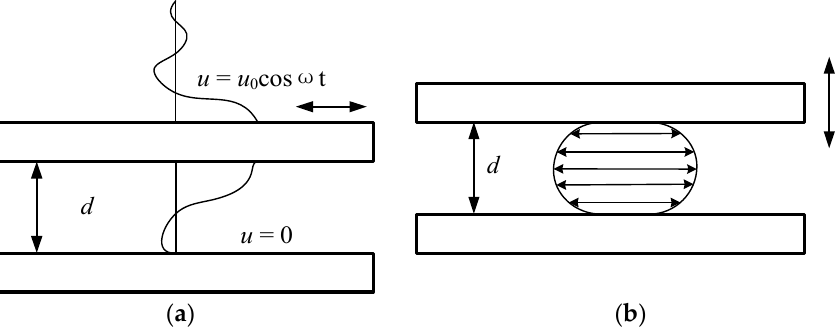
Figure 4. Viscous damping model: ( a ) slide film damping model; ( b ) squeezing film damping model [28].